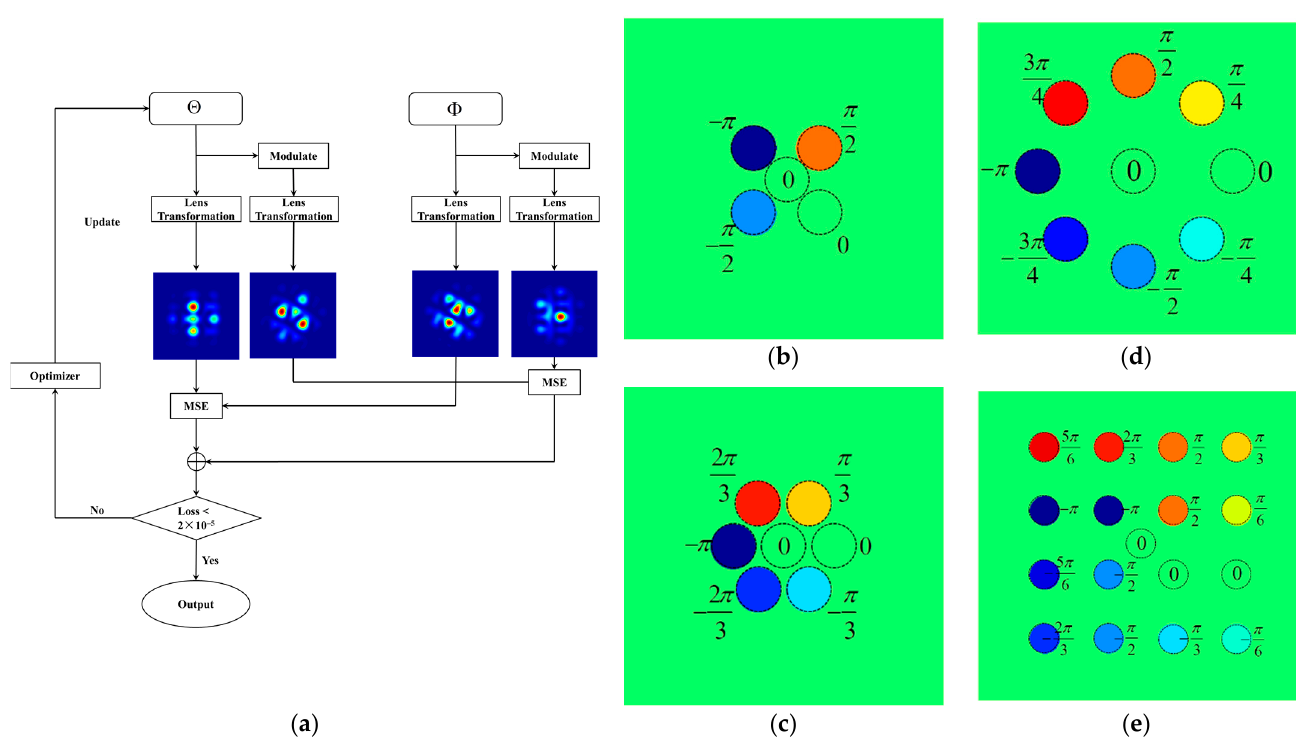
Figure 7. ( a ) In the process, we not only make Θ generate the samiliar far-field to Φ , but also make modulated Θ generate the samiliar far-field to modulated Φ ; ( b ) The modulation phase we use in the 5-element system; ( c ) The modulation phase we use in the 7-element system; ( d ) The modulation phase we use in the 9-element system; ( e ) The modulation phase we use in the 17-element system. If our method works, the solutions are only distributed near Φ . We can see that modu- lated Φ and modulated Φ will no longer generate the far field from Figure 8, which indicates are consistent with our conclusions, which indicates that our method is